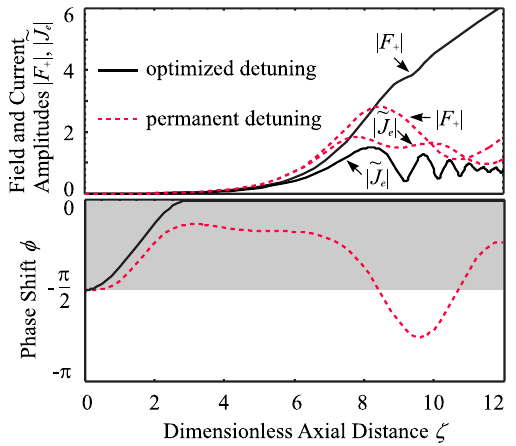
FIG. 7. The simulation results for the FEL with and without the phase shift optimization are